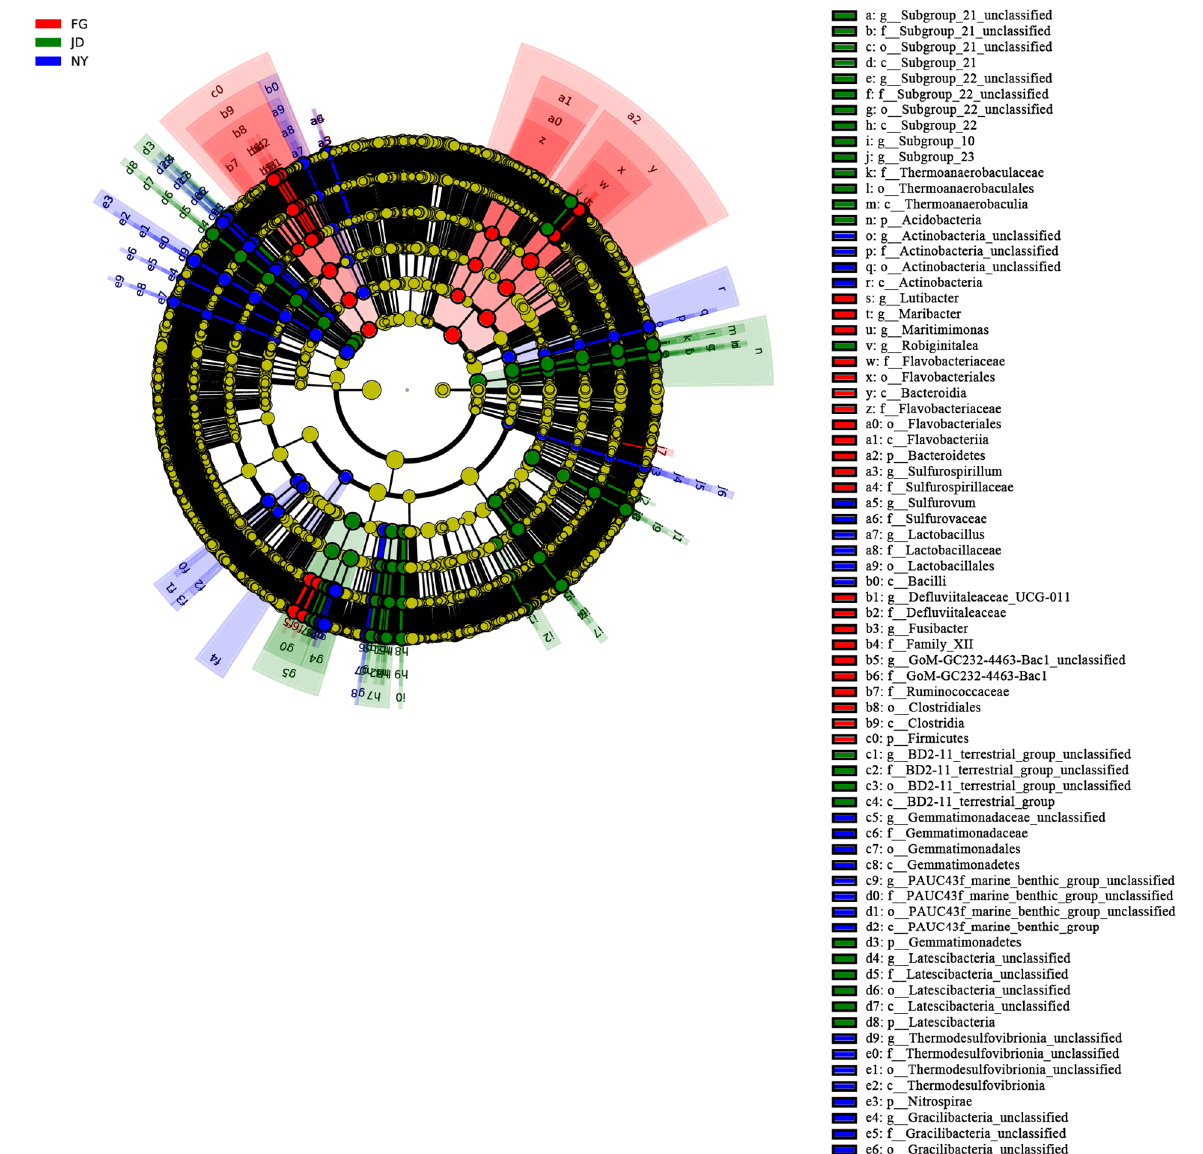
Figure 5. LEfSe showing the significant differences at different bacterial taxonomic levels among the CT, SC, and MR treatments. Different colored dots represent the taxa with significant differences among all treatments. The inner to outer circles represent taxa from phylum to species.